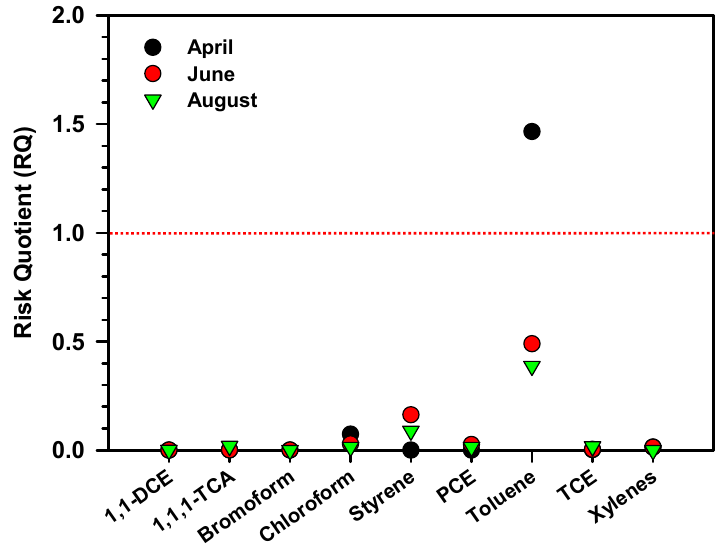
Figure 6. Risk quotients calculated for VOC concentrations in tributaries of the Han River basin.